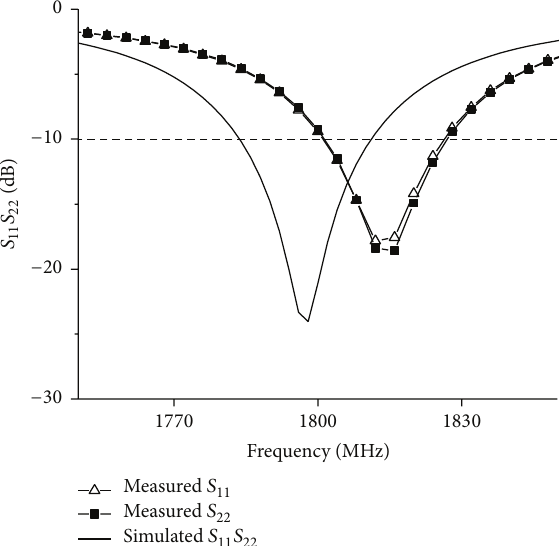
Figure 5: Simulated and measured return loss of the antenna.